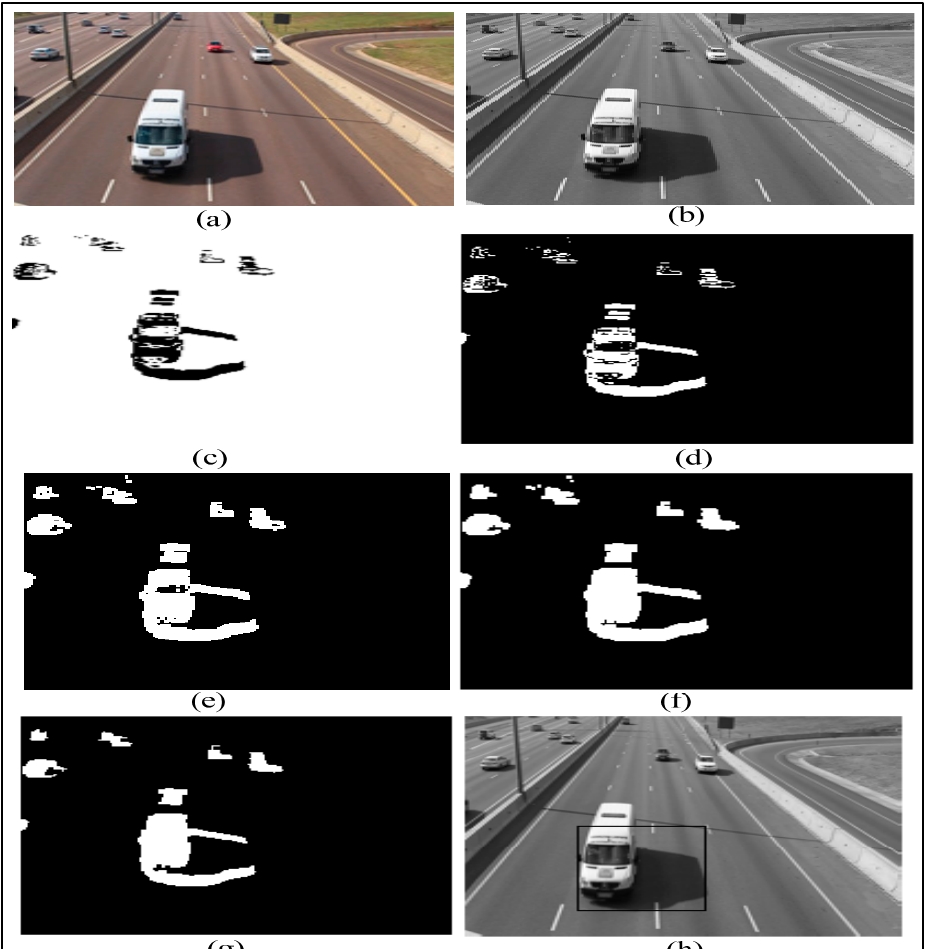
Figure 14. Emergency vehicle detection process: ( a ) RGB frame; ( b ) Grayscale frame; ( c ) Difference image; ( d ) Binary image; ( e ) Dilated image; ( f ) Hole filling image; ( g ) Eroded image; ( h ) Tagged Vehicle.